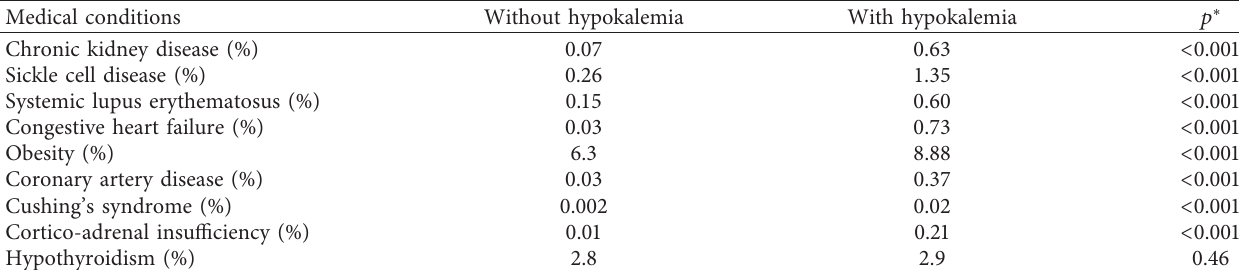
Table 2: Medical conditions of pregnancy-related admissions for women with and without hypokalemia.